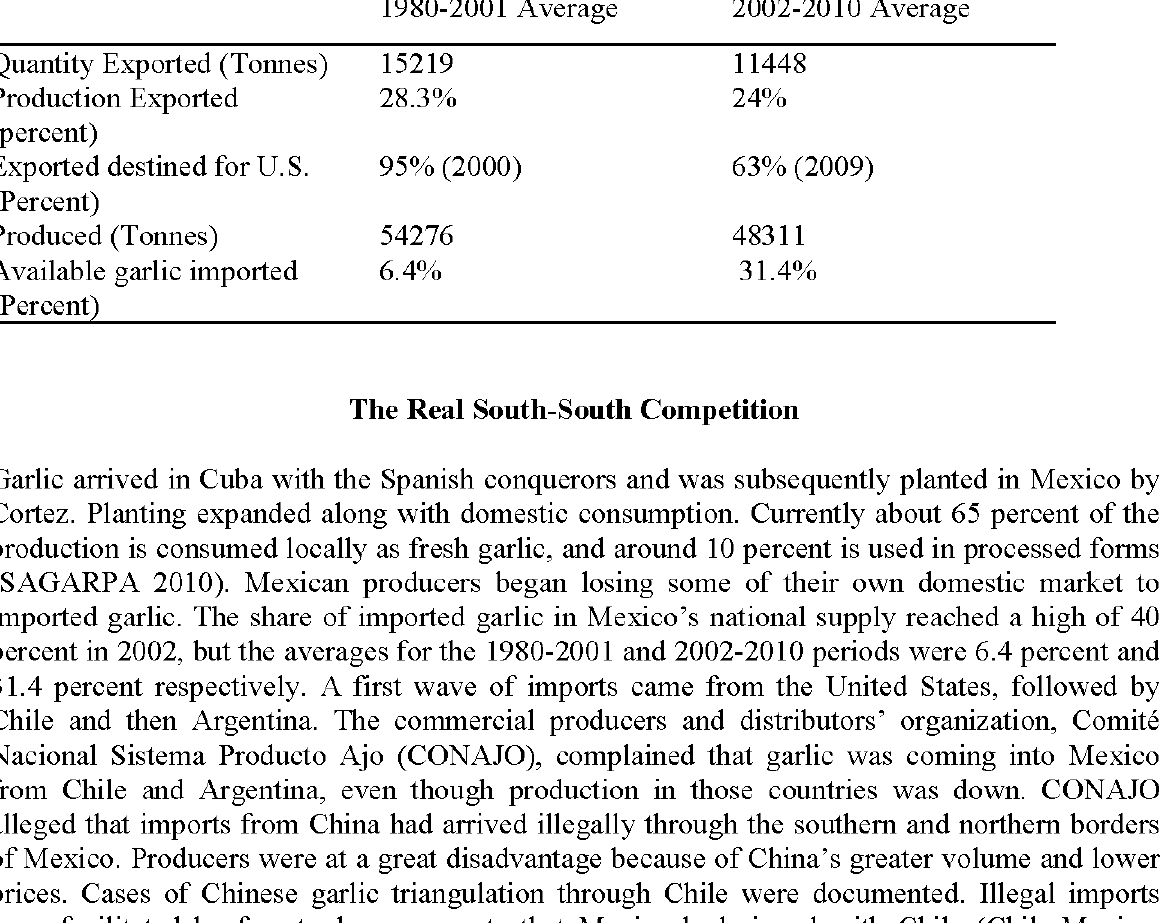
Table 5. Mexico's Declining Garlic